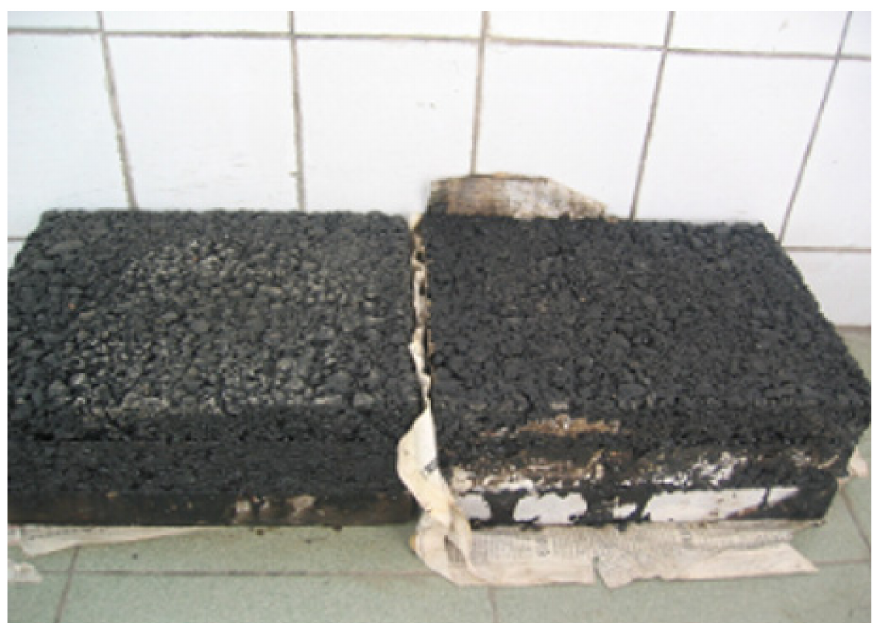
Figure 3. Formed bridge deck pavement